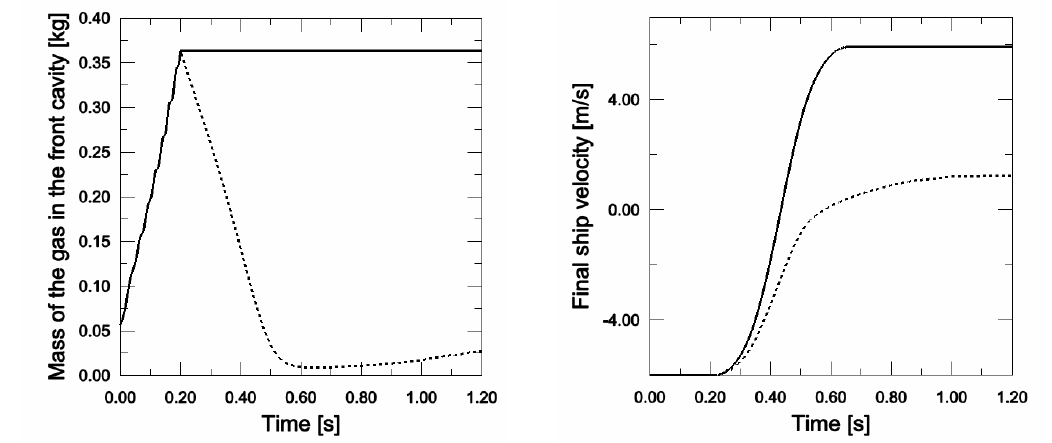
Fig. 9. Passive case (continuous line) and semi-active adaptation with pressure release (dashed line): a) mass of the gas in the front cavity, b) corresponding velocity of the ship.